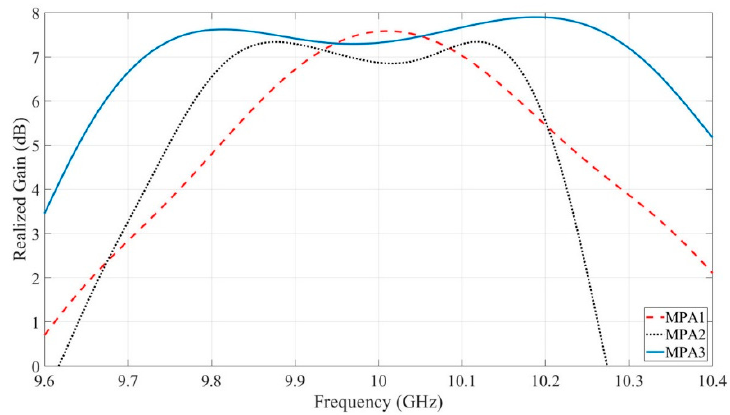
Figure 10. Realized gain vs. frequency for MPA1, MPA2, and MPA3. Two modified versions of MPA2 and MPA3, namely MPA4 and MPA5, fed by